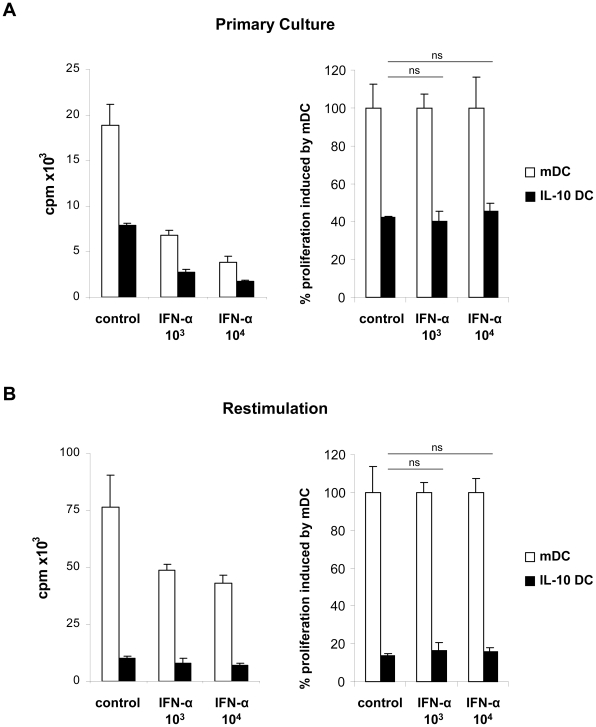
IFN-α did not interfere with priming or perpetuation of T cell anergy.(A) CD4+ T cells were cocultured with allogeneic mDC or IL-10 DC and incubated with concentrations of IFN-α as indicated. After 5 days, T cell proliferation was assessed by [3H] thymidine incorporation, results are depicted in absolute cpm +/− SD (left panel) and in percentages +/− SD (100% = T cell proliferation induced by mDC) (right panel). One representative experiment of 3 is shown. (B) CD4+ T cells primed with allogeneic mDC or IL-10 DC were restimulated with anti-CD3/anti-CD28 in the presence of increasing concentrations of IFN-α as indicated. T cell proliferation was detected after 72 hours of restimulation as described. Results are shown in absolute cpm +/− SD (left panel) and in percentages +/− SD (normalized to proliferation induced by mDC = 100%) (right panel). One representative experiment of 2 is demonstrated. n.s. not significant.